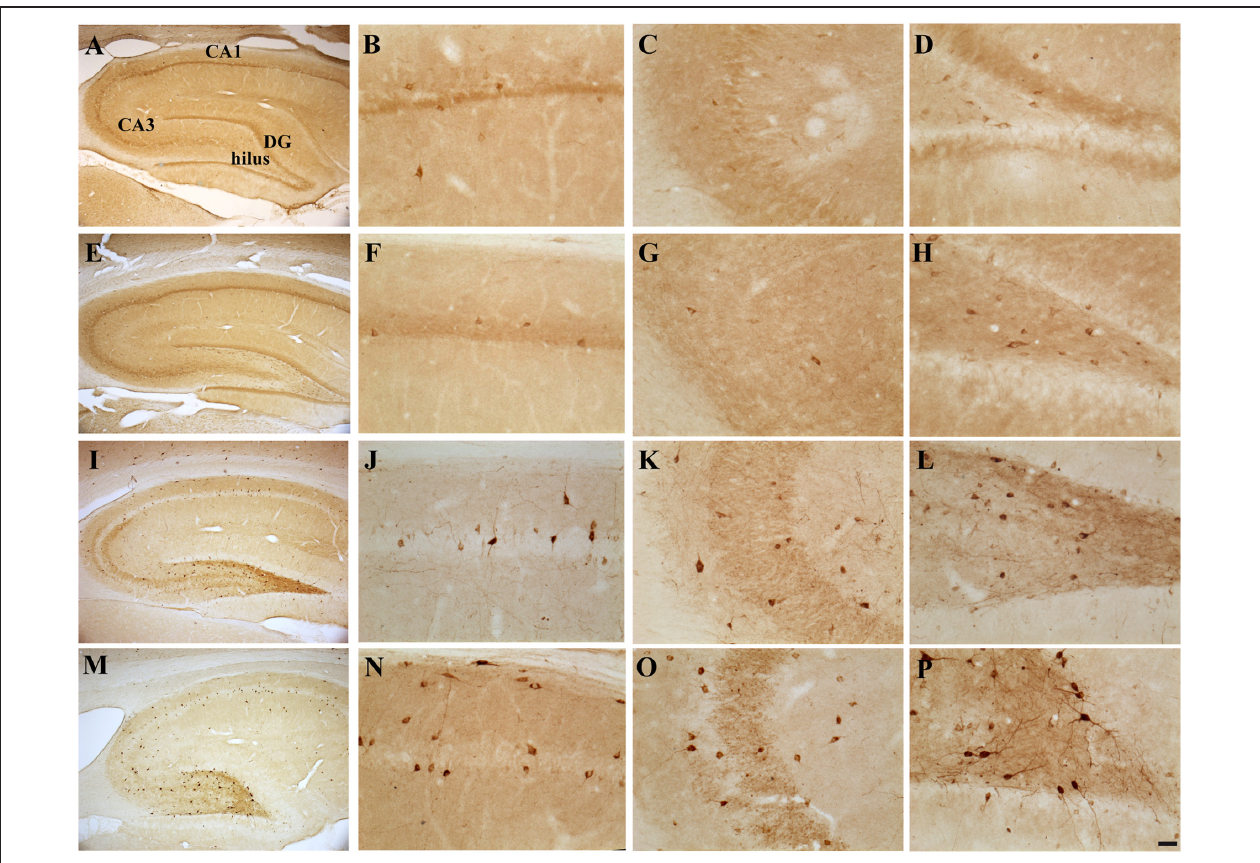
FIGURE 6 | Hippocampal distribution of neuropeptide Y (NPY)-immunoreactive interneurons in the different experimental groups. Representative micrographs of NPY-stained hippocampal sagittal sections from the the whole hippocampus (A,E,I,M) , CA1 (B,F,J,N) , CA3 (C,G,K,O) and hilus (D,H,L,P) from CTRL + oil- (A–D) , CTRL + E2- (E–H) , TMT + oil- (I–L) and TMT + E2- (M–P) -treated rats. A higher number of darkly stained NPY-IR neurons is evident in CA1, CA3, and hilus of both TMT-treated groups compared with CTRL groups, being also more pronounced in the TMT + E2-treated animals. Scale bar: 200 μ m